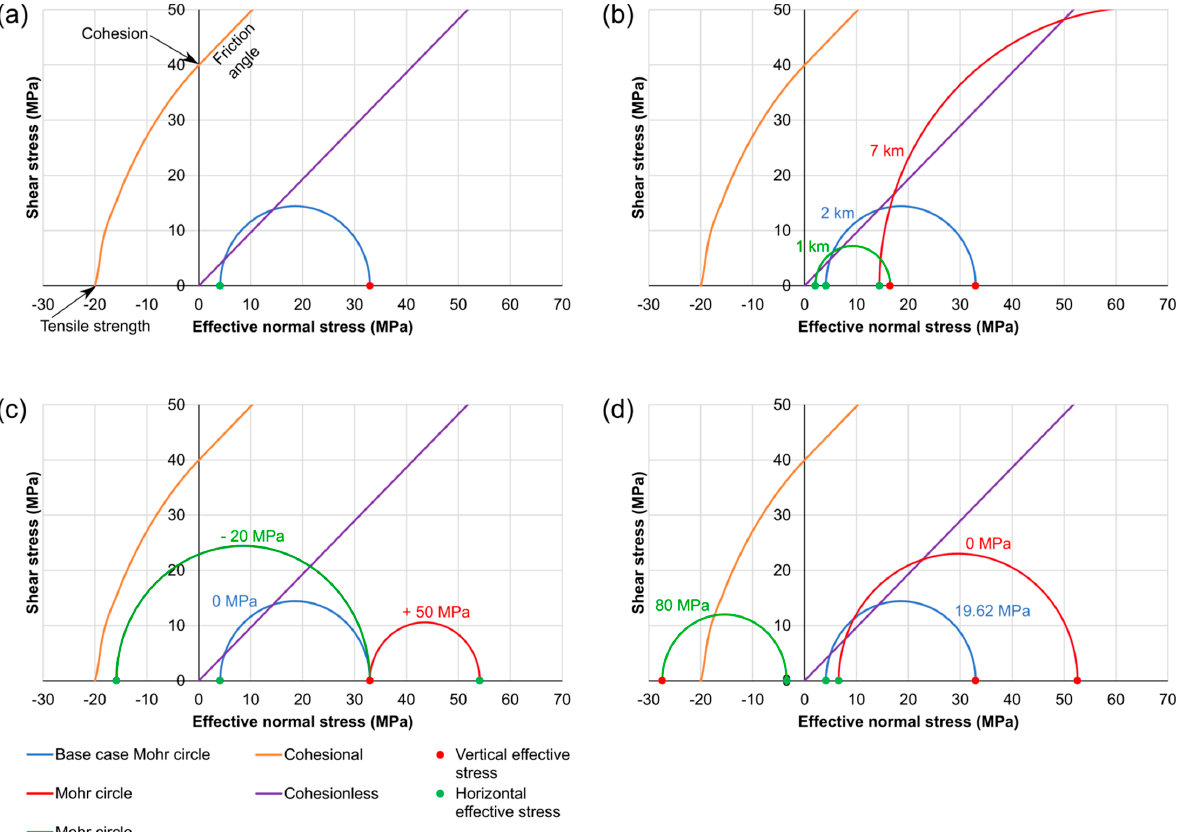
Figure 4. Mohr diagrams showing the effects of key parameters on the failure envelope and state of effective stress, all shown using the model for the Devonian and Carboniferous greywackes with a geostatic stress ratio of 0.125. The parameters used are shown in Table 3. ( a ) The base case Mohr circle (depth of 2 km, hydrostatic fluid pressure and no applied tectonic stress), with a representative cohesional failure envelope shown (Table 3, “Greywacke” and “Slate” columns). “Friction angle” refers to the slope the failure envelope. ( b ) Mohr circles for effective stress at different depths (hydrostatic fluid pressure and no applied tectonic stress). The magnitudes of the effective stresses increase with depth. ( c ) Mohr circles for a depth of 2 km, hydrostatic fluid pressure and different applied tectonic stresses. ( d ) Mohr circles for a depth of 2 km, different fluid pressures and zero applied tectonic stresses.